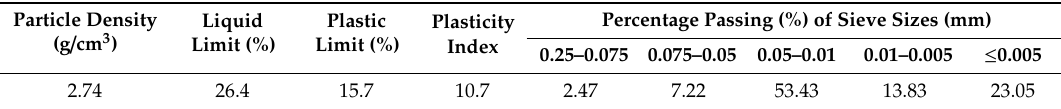
Table 1. Physical properties of loess.